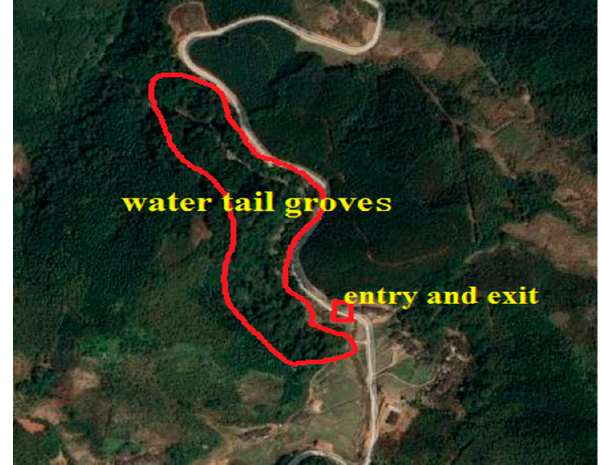
Figure A4. Geographical features of Gaoshan Village.